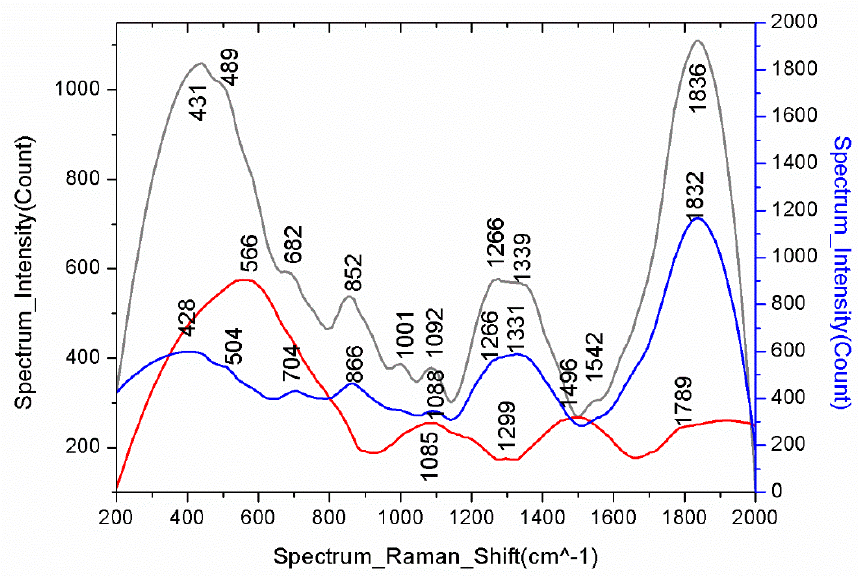
Figure 8. Raman spectra of the investigated samples (red pigment—red line in the spectrum; blue pigment—blue line in the spectrum; green pigment—dark green line in the spectrum).